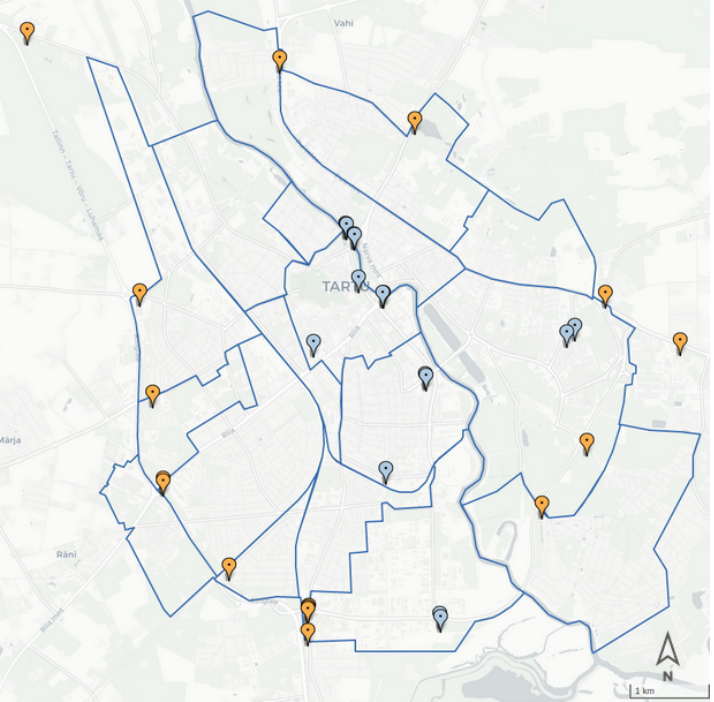
Figure 6. Locations of AVC Vehicle counters (orange) and Thinnect counters